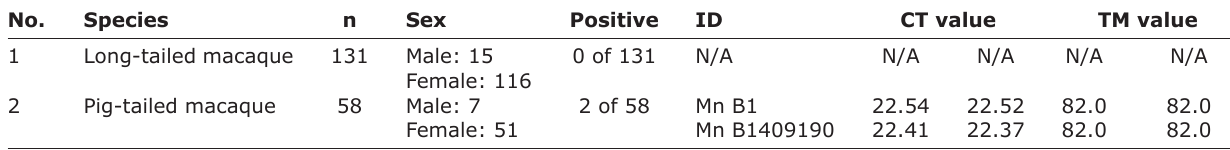
Table-2: Summary of SERV detection using SYBR Green real-time PCR technique on long-tailed macaque and pig-tailed macaque samples in breeding captivity in Bogor, Indonesia. No. Species n Sex Long-tailed